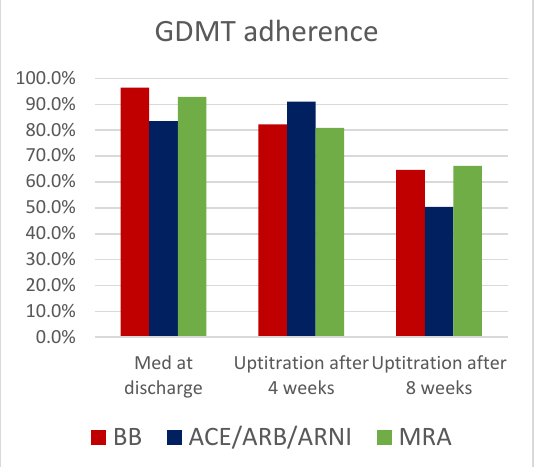
Figure 2. Rate of GDMT adherence and uptitration at discharge, after 4 and 8 weeks.